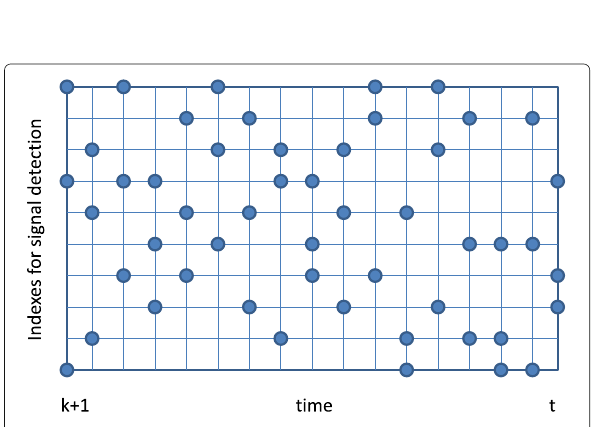
Fig. 2 A sampling pattern when A t is a 0-1 matrix, M = 3, and N = 10. Dots represent entries being observed